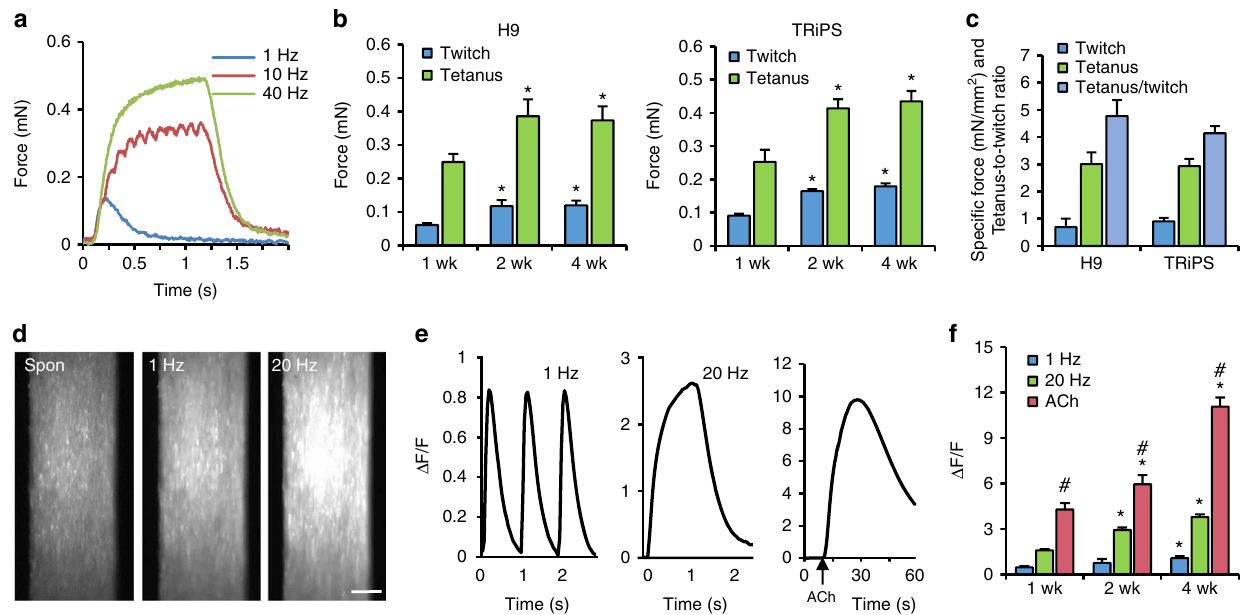
Fig. 4 Contractile properties of hPSC-derived iSKM bundles. a Representative contractile force traces of a 4-week TRiPS-derived bundle shows increase in contractile force with increase in stimulation frequency and formation of tetanic contraction. b Increase of twitch and tetanus (at 40 Hz) force with time of culture. (* P < 0.05 vs. 1 week, Tukey-Kramer HSD test; n = 6 – 8 bundles per group at each time point). c Speci fi c force and tetanus-to-twitch ratio of 2- week H9 and TRiPS derived bundles ( n = 10 bundles for H9, 12 bundles for TRiPSC). d Representative peak GCaMP6 fl uorescence images during spontaneous (spon) and electrically stimulated calcium transients in 2-week bundles. Scale bar = 100 µ m. e Representative traces of GCaMP6 signal from 1 Hz, 20 Hz, and acetylcholine (ACh, 10 mM) stimulated 2-week bundles. f Amplitude of electrically stimulated and ACh induced calcium transients increase with time of bundle culture. (* P < 0.05 vs. 1 week, # P < 0.05 vs. 20 Hz, Tukey – Kramer HSD test; n = 4 – 8 bundles per group at each time point). Data